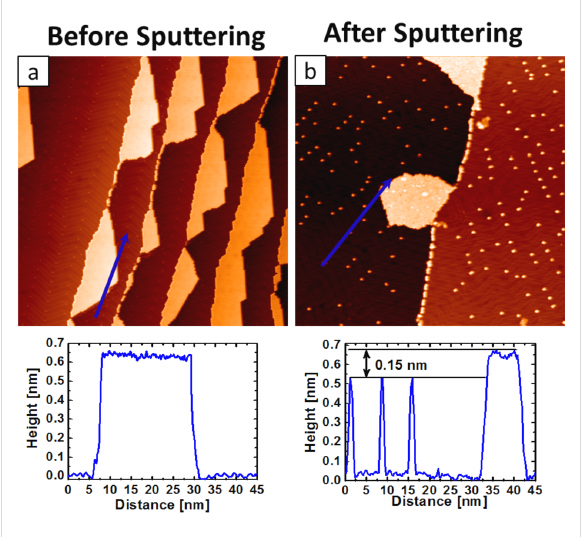
Figure 1: (a) (200 × 200 nm 2 ) High-resolution STM image ( U b = − 0.5 V, I s = 0.3 nA) of Au (111) after deposition of C 60 . The mol- ecules formed self-assembled islands, attached to the surface-terrace edges as expected. (b) (200 × 200 nm 2 ) High-resolution STM image ( U b = − 0.6 V, I s = 0.3 nA) of the system after sputtering with 120 eV Ar + ions for 5 min. Single molecules were detached from the islands as the result of the sputtering process. Profiles measured along the indi- cated blue arrows reveal the apparent height differences between iso- lated molecules and those inside the